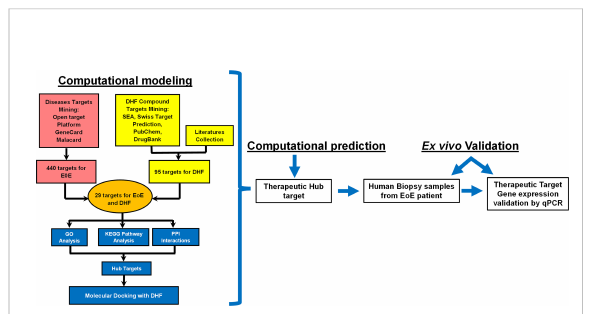
FIGURE 1 The work fl ow of computational modeling used for analysis of